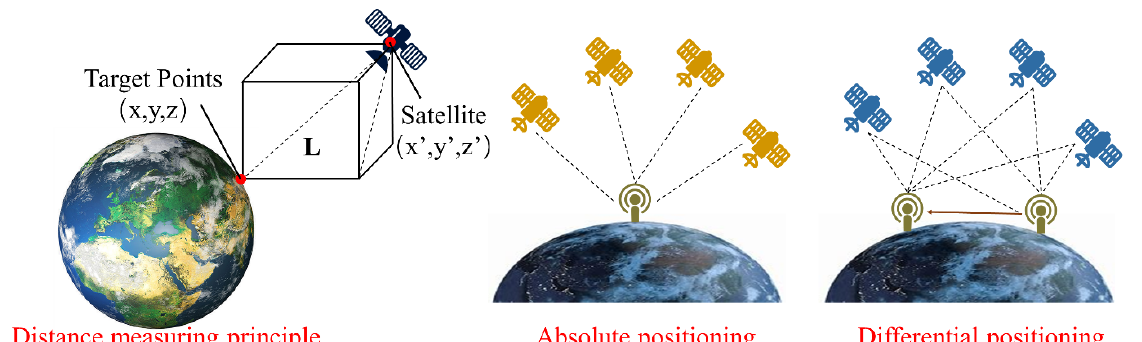
Figure 2. Satellite positioning principle.